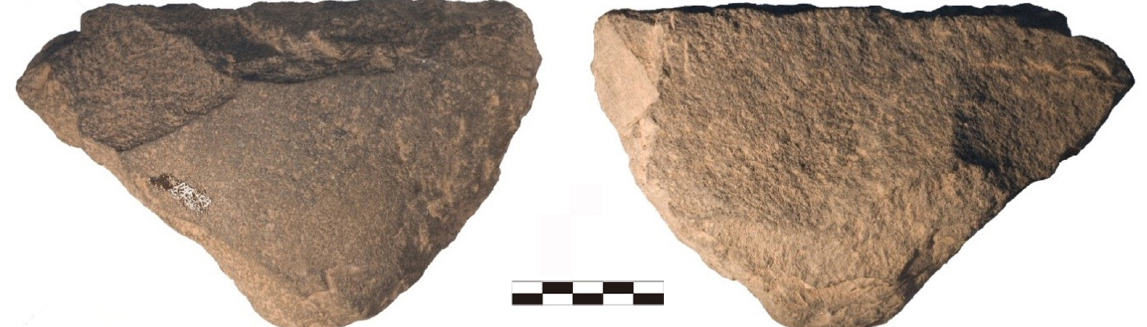
Figure 5. Views of a stone pick serving to extract rotary querns from the quarry of Montaña Quemada, Las Palmas de Gran Canaria. The scale bar is 5 cm (1 cm